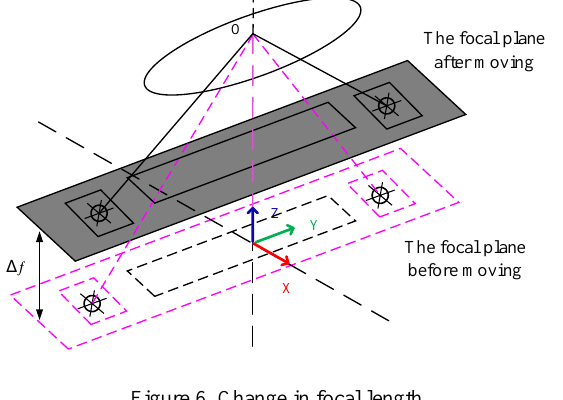
Figure 6. Change in focal length